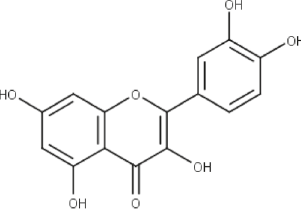
FIGURE 10 - Multi-target flavonoid that possessed an activity in the NS2B-NS3 complex.